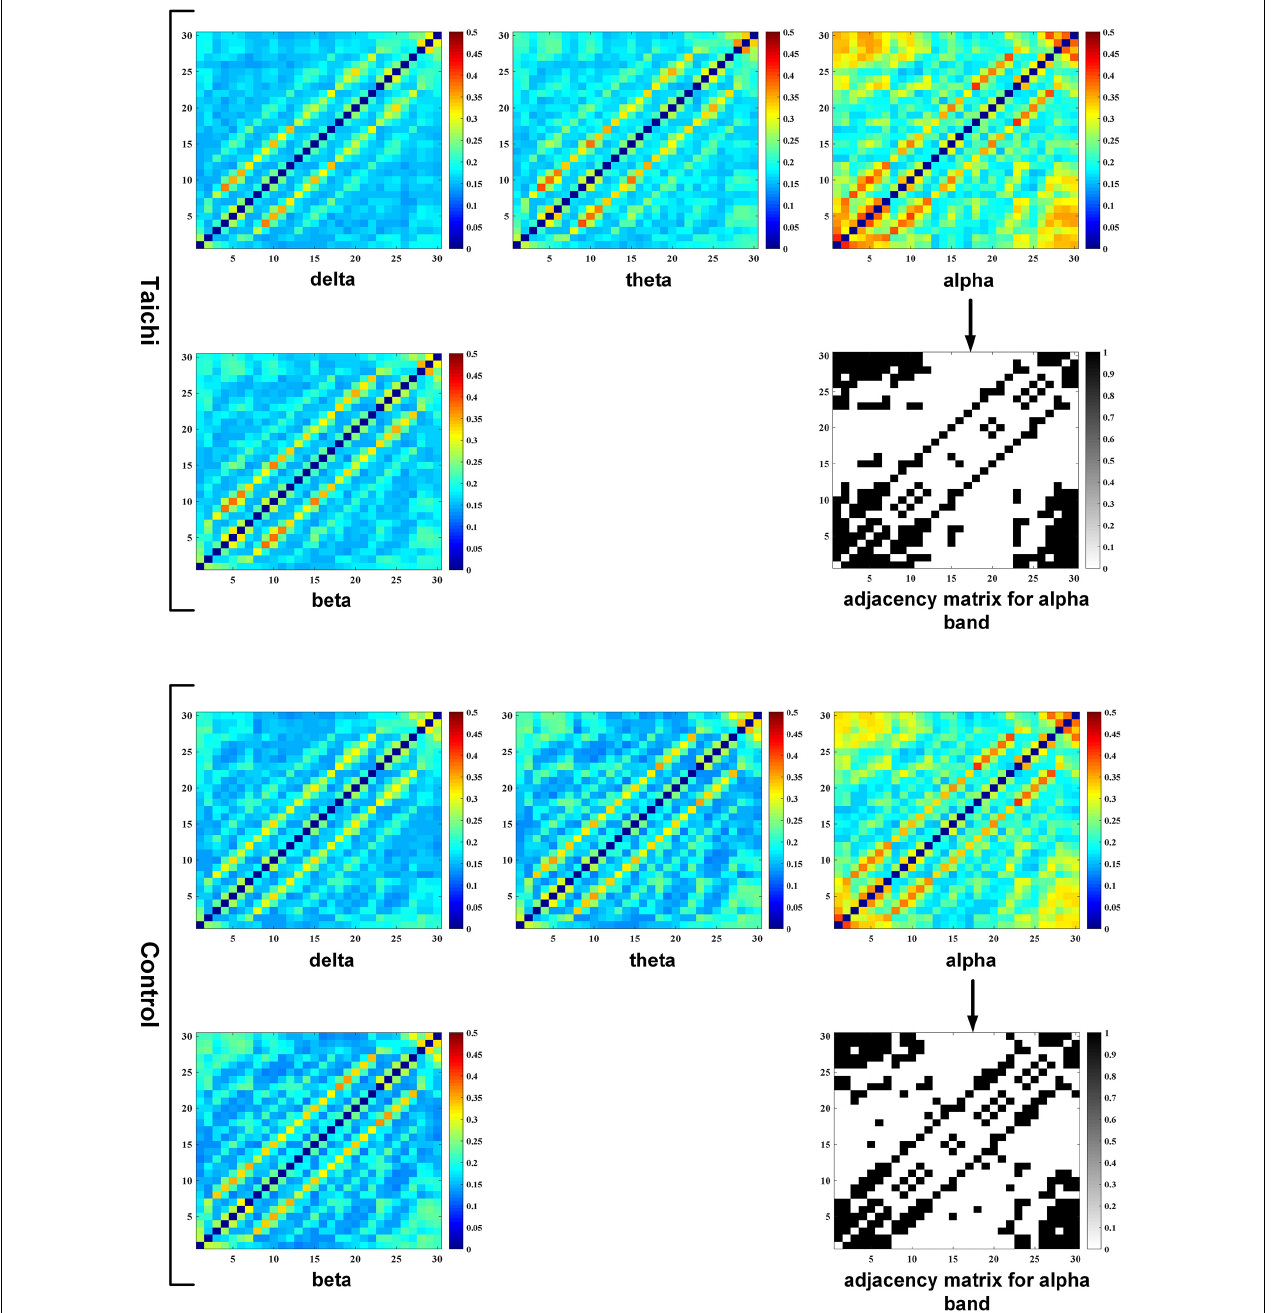
FIGURE 4 | PLV correlation matrix and adjacency matrix of TC and